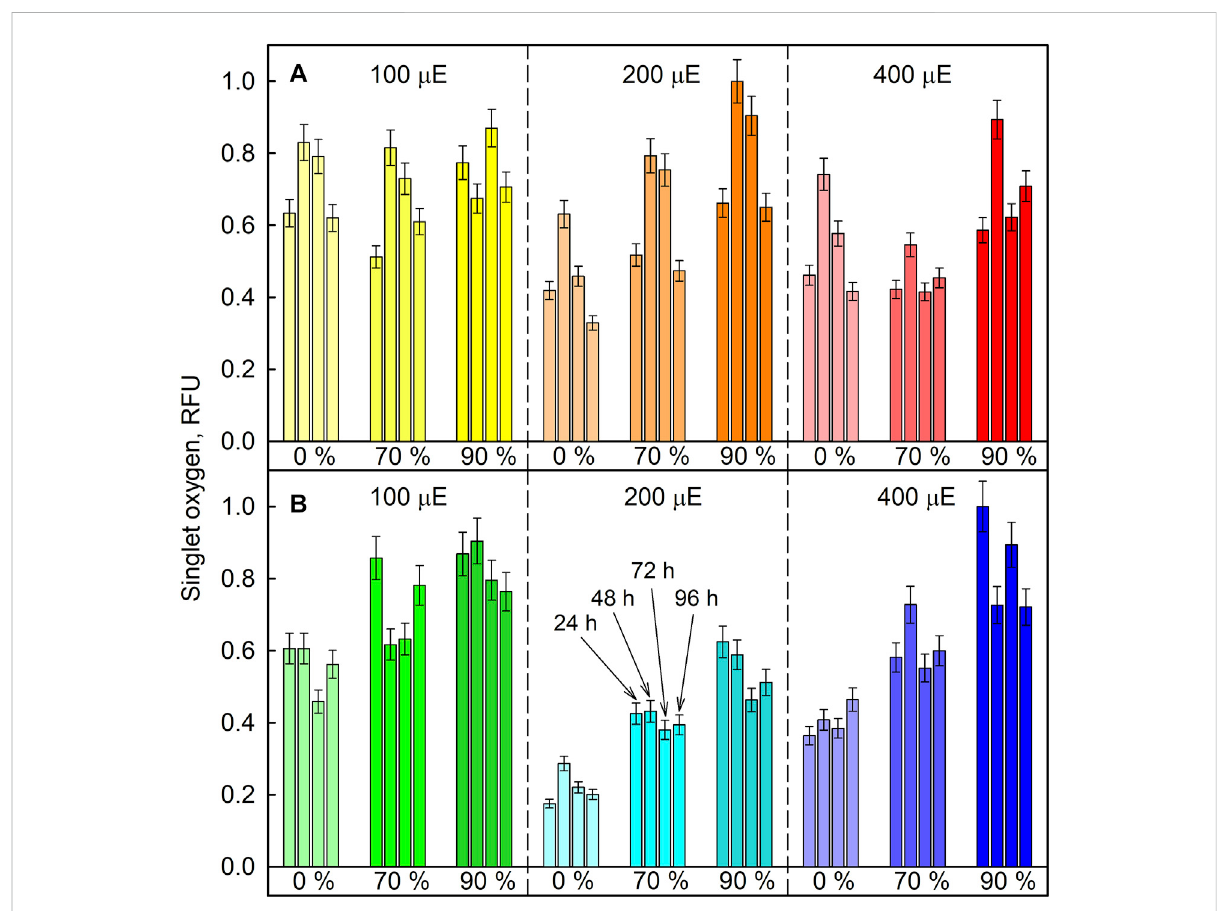
FIGURE 13 Relative amount of singlet oxygen in cultures grown at different incident light intensities (100, 200, and 400 µmol photons · m − 2 · s − 1 ) and at differentD 2 O concentrations (0%, 70% and 90%, indicated as percentagesunder the bars) in D. quadricauda (A) and C.reinhardtii (B) . Singlet oxygen levels were determined spectrophotometrically and fl uorescence was normalized to the maximum value. Individual bars within one group (same color) represent individual measurements after 24, 48, 72, and 96 h of cultivation (as indicated in panel B). Light intensities are given in μ E (instead of µmol photons · m − 2 · s − 1 ), in order to fi t the